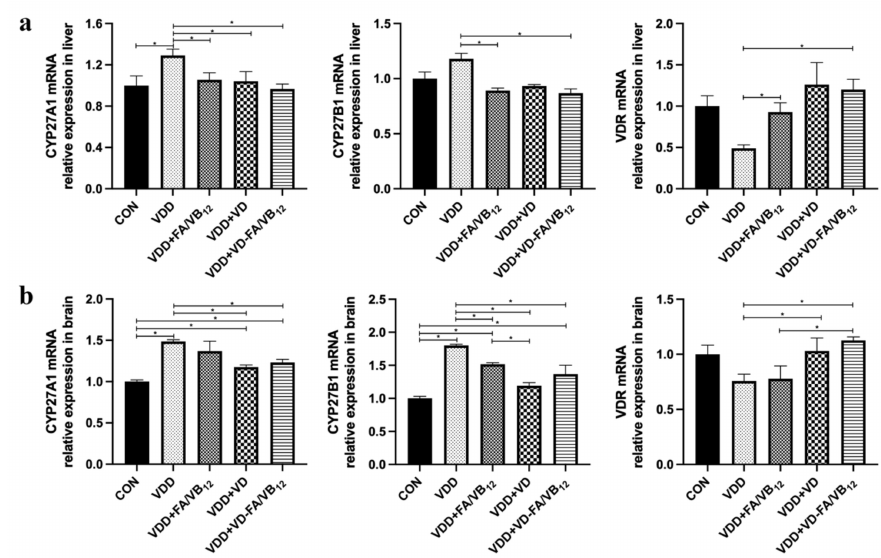
Figure 6. The gene expression of CYP27A1, CYP27B1, and VDR in liver and brain. ( a ) CYP27A1, CYP27A1and VDR mRNA in livers; ( b ) CYP27A1, CYP27A1and VDR mRNA in brains. CON: control; VDD: vitamin D-deficient diet; VDD + FA/VB 12 : vitamin D-deficient diet plus folic acid/vitamin B 12 supplement; VDD + VD: vitamin D-deficient diet plus vitamin D supplement; VDD + VD-FA/VB 12 : vitamin D-deficient diet plus vitamin D and folic acid/vitamin B 12 . All data are presented as the mean ± SEM ( n = 4). A two-sided p < 0.05 was considered statistically significant.